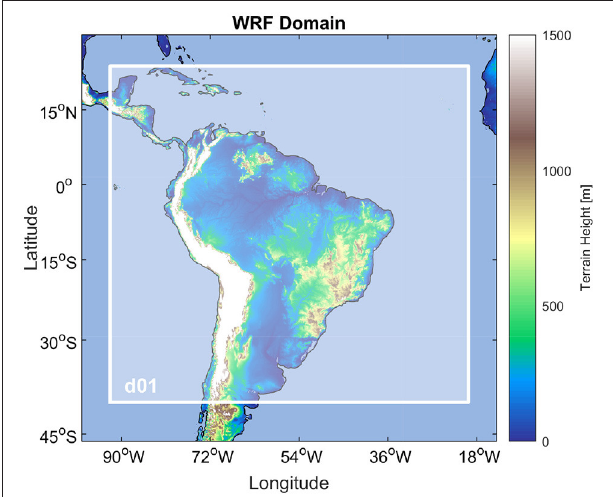
FIGURE 1 | WRF Domain for all numerical experiments are represented in the white shaded area and labeled by d01. The map illustrates the terrain height (in meters) for continental areas. The Andes mountain height is saturated in the map in order to highlight the central Brazil topography.